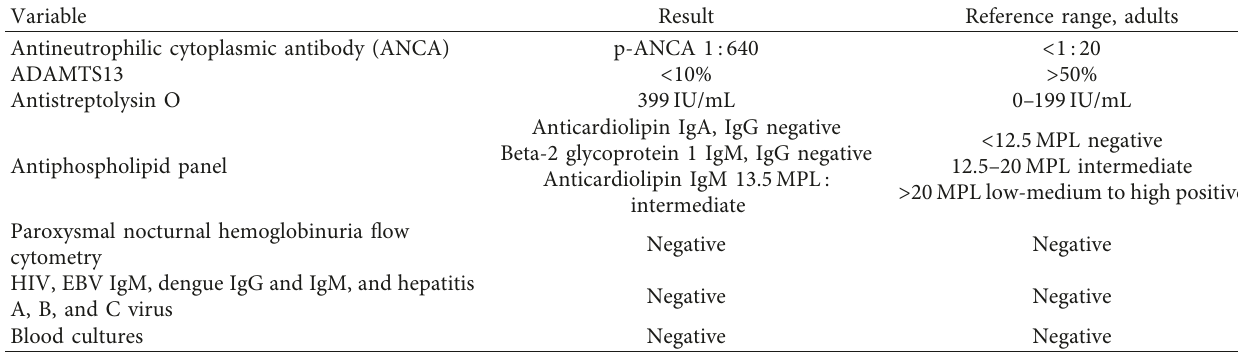
Table 2: Laboratory test results after 24 hours.